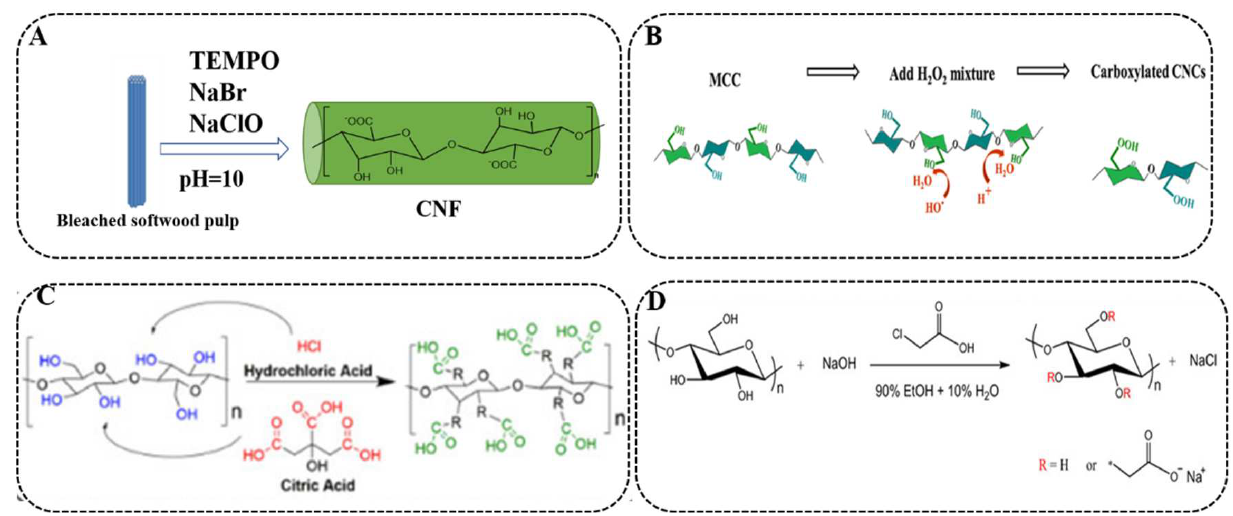
Figure 3. Carboxyl formation sites in various reaction systems: ( A ) TEMPO oxidation, ( B ) Fe 2+ /H 2 O 2